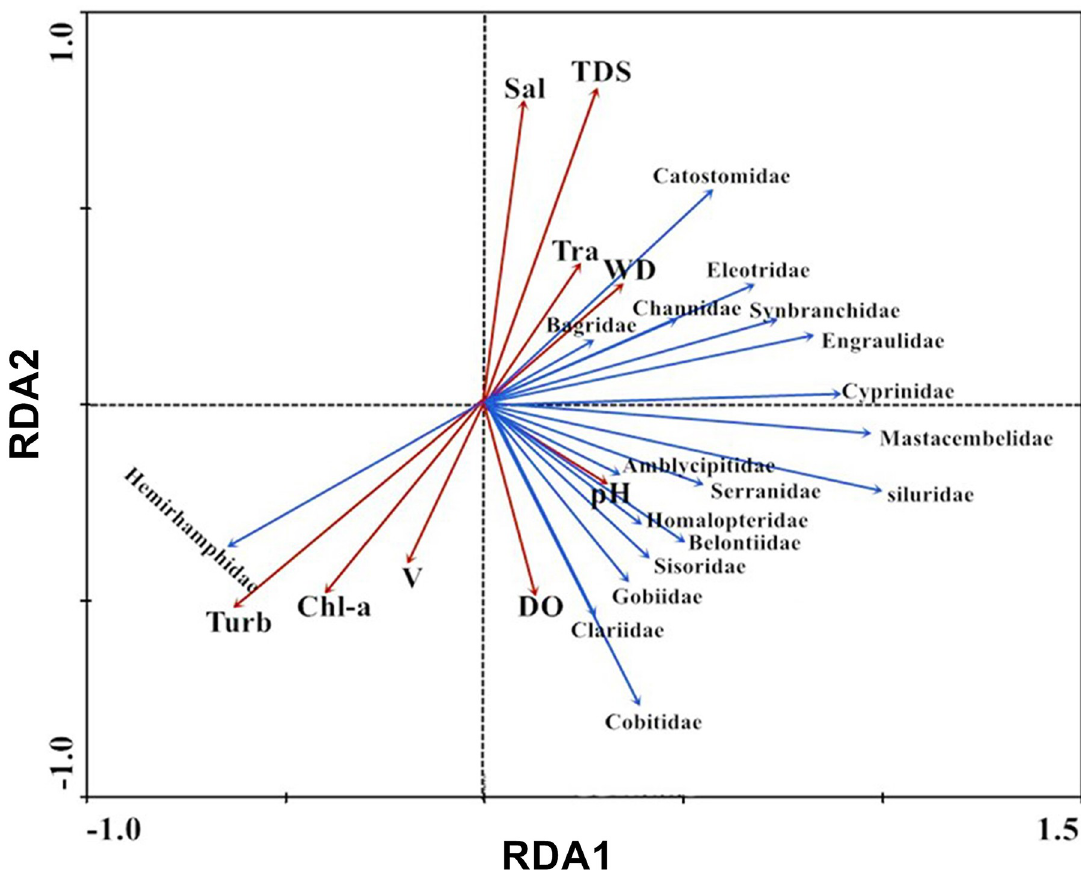
Fig 5. Ordination biplot of fish species assemblages and environmental variables obtained by RDA across sampling periods and sites.